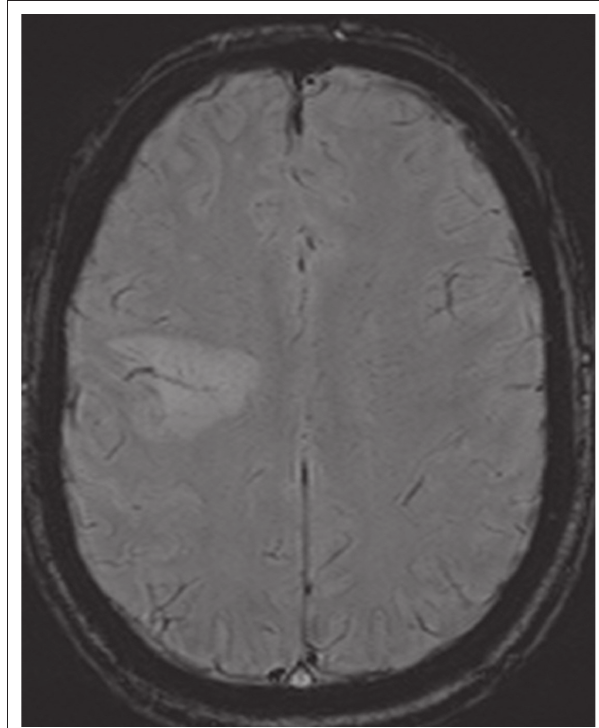
FIGURE 1: Axial FLAIR MR image. FIGURE 2: